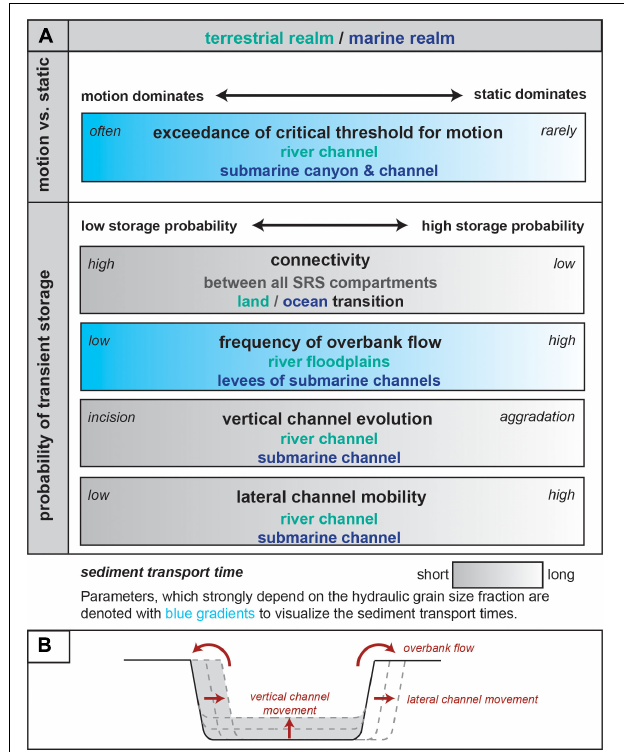
FIGURE 5 | Schematic summary of factors influencing sediment transport times in channelized systems. (A) Sediment transport times depend on the fraction of time a grain is in motion versus immobile within the active channel, and the probability of storage outside the active channel. Both, the time in motion and probability of storage, depend on a range of factors, which themselves range between endmembers as indicated in italics. Accordingly, the sediment transport times range from short (dark colors) to long (white colors). Factors that vary greatly with hydraulic grain size fraction are marked in blue, factors that vary less between grain sizes are shown in gray. Green and blue font indicates the locations where these factors apply in the fluvial and marine realm, respectively. (B) Schematic summary of channel evolution